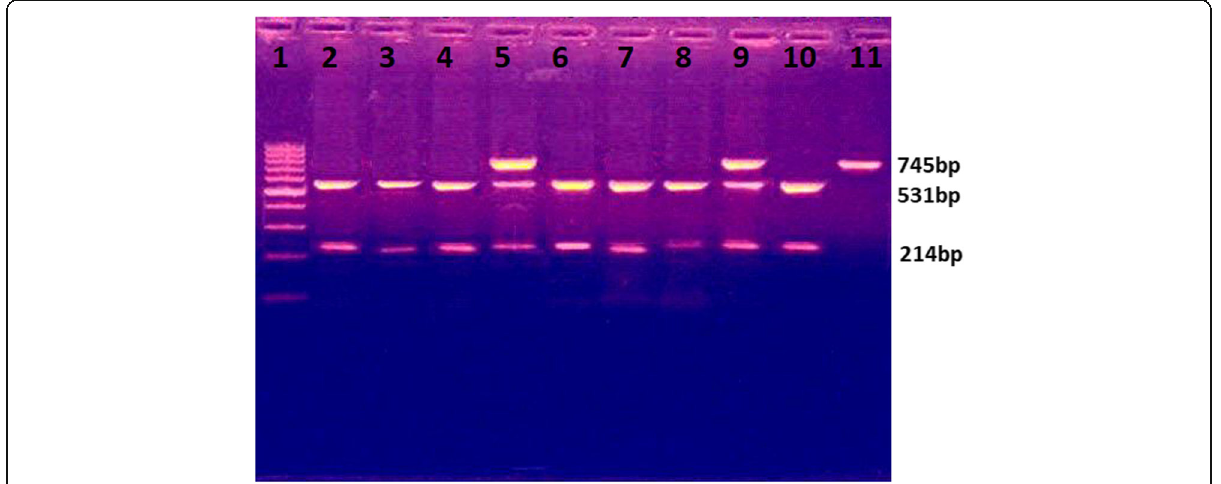
Fig. 1 2% Agarose gel stained with ethidium bromide of APa1 PCR genotyping reaction. CC homogenous genotype show two bands of 531 and 214 bp, The CA heterogenous genotype show three bands of 745, 531, and 214 bp, AA homogenous genotype show single bands of 745